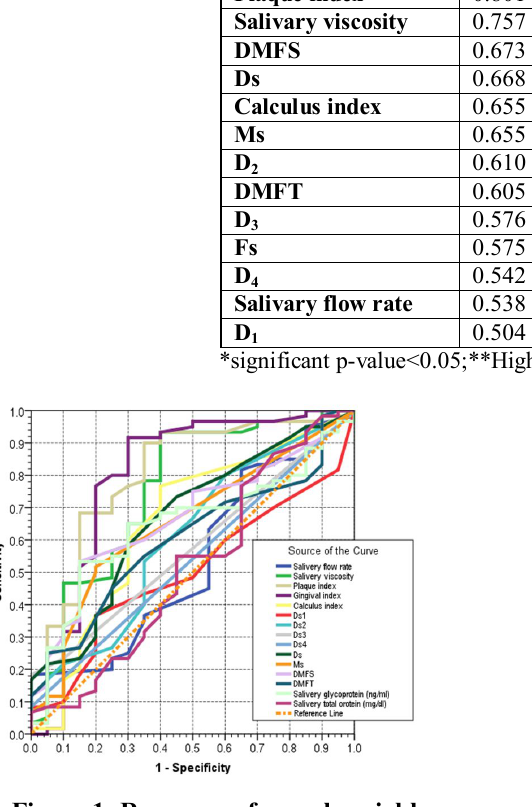
Figure 1: Roc curves for oral variables. Figure 2: Roc curves for selected oral variables (salivary PH and